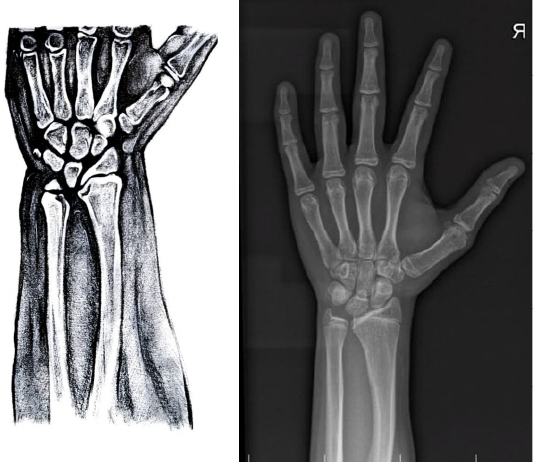
Figure 6. Radiological findings in SHOX deficiency (adapted from Vanelli et al. 2020).